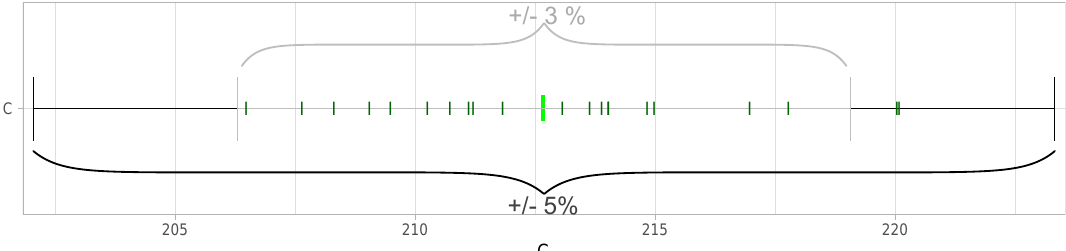
Figure 3. Calibration factor for winter 2017/2018. Light green I: median of all C i ; dark green I: median of C i , when using only one profile at a time; grey: seasonal median of C i ± 3%; black: seasonal median of C i ±